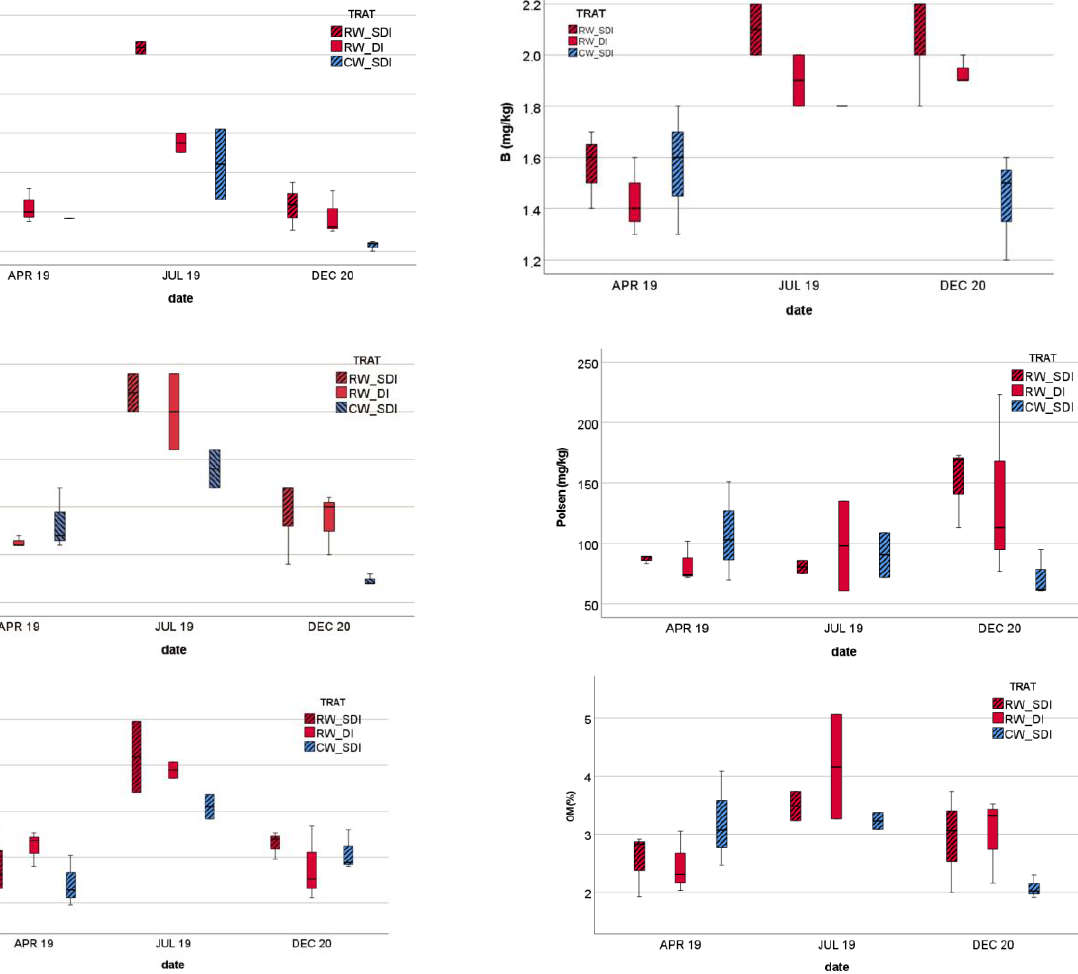
Figure 2. Soil affected by treatment: nitrate, B and N tot showed significant differences at the 0.05% level, and P showed a significant difference at the 10% level, but Na and OM showed no significant